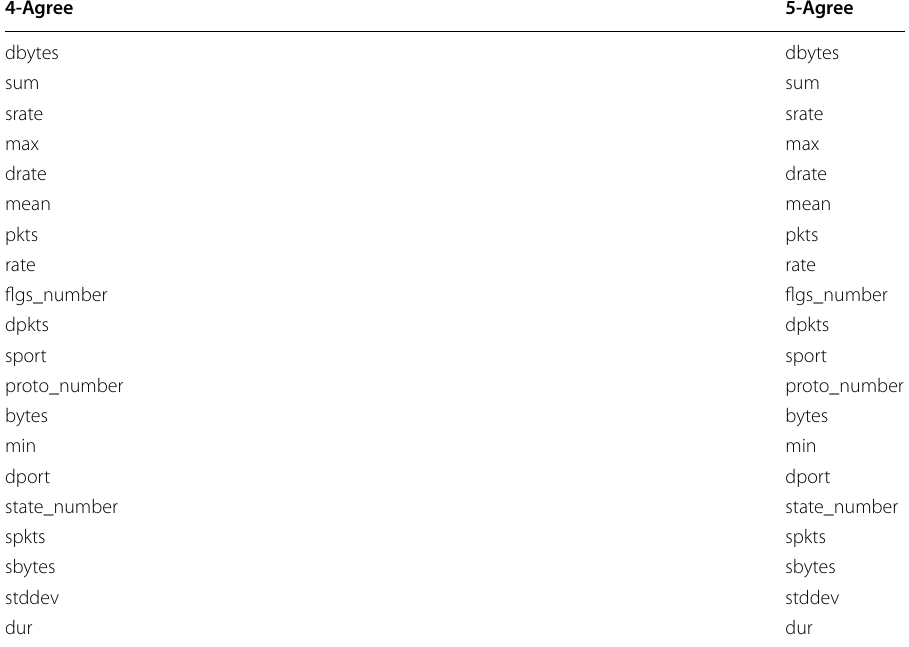
Table 53 Results of the 4-Agree and 5-Agree FSTs 4‑Agree